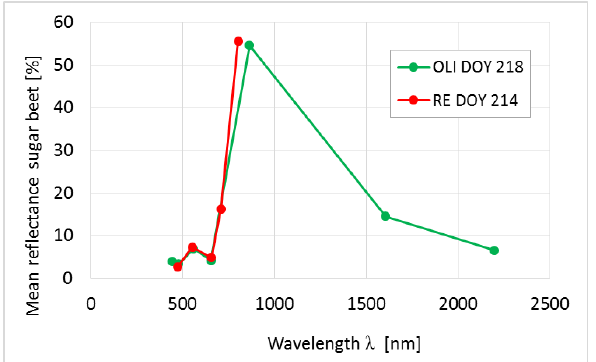
Figure 5: Reflectance measured for Sugar Beet with Landsat 8 OLI and RapidEye